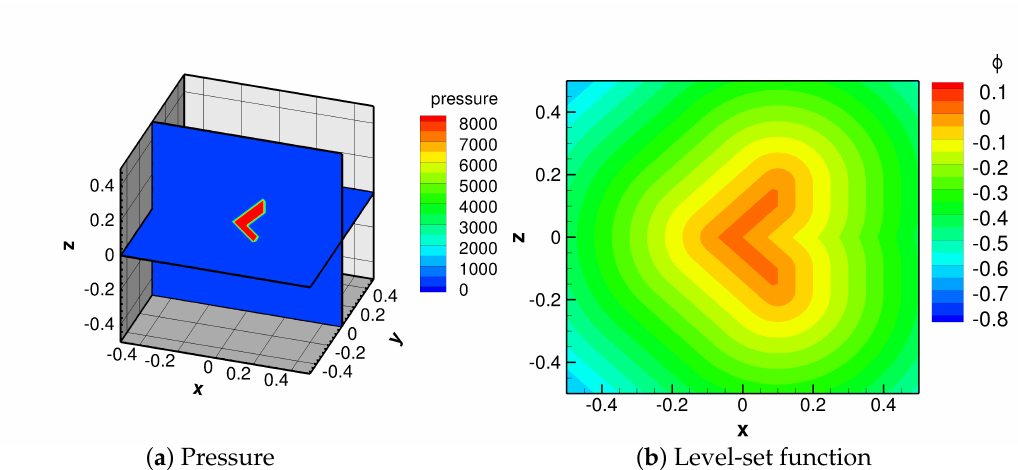
Figure 10. The initial setup of the UNDEX simulation with a high-pressure gas bubble in a bullet-like shape. The configurations of the figure are similar to Figure